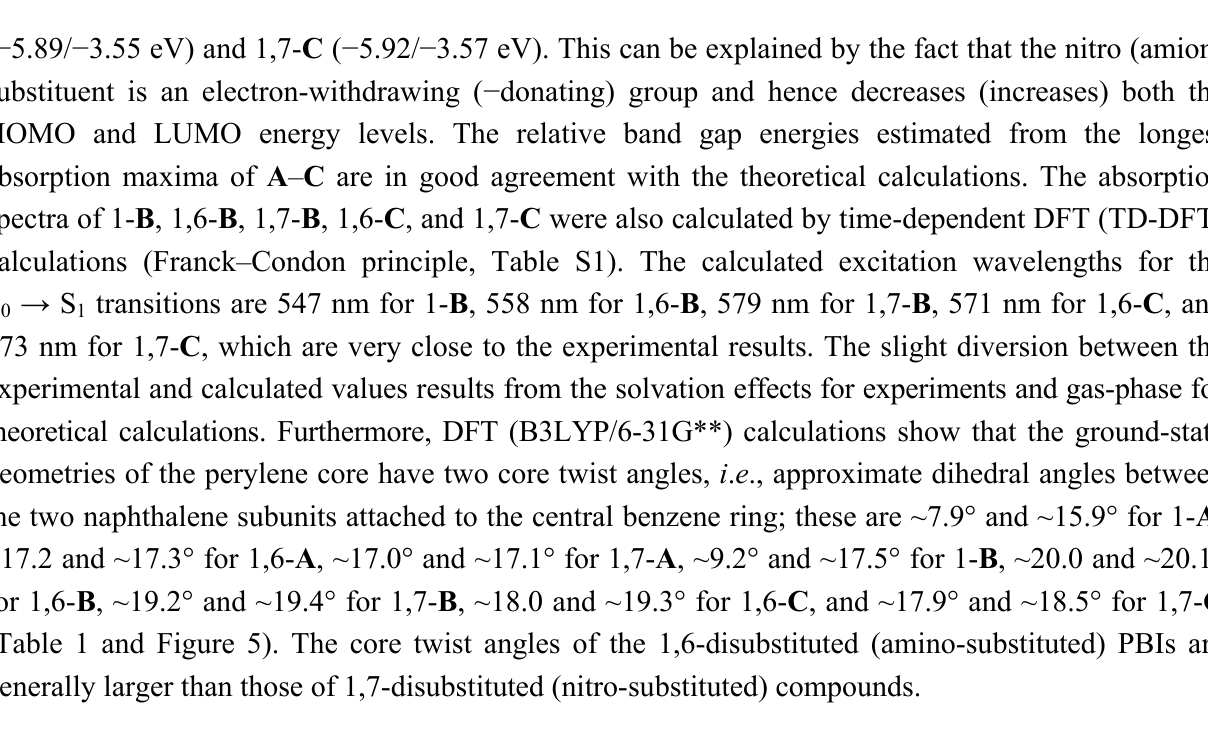
Figure 4. Computed frontier orbitals of 1,6- B , 1,7- B , 1,6- C , and 1,7- C . The upper graphs are the LUMOs and the lower ones are the HOMOs [53].